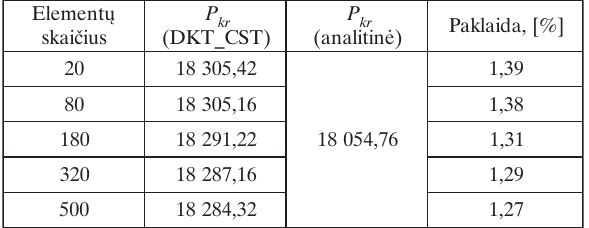
Table 2. The first critical force. Results of